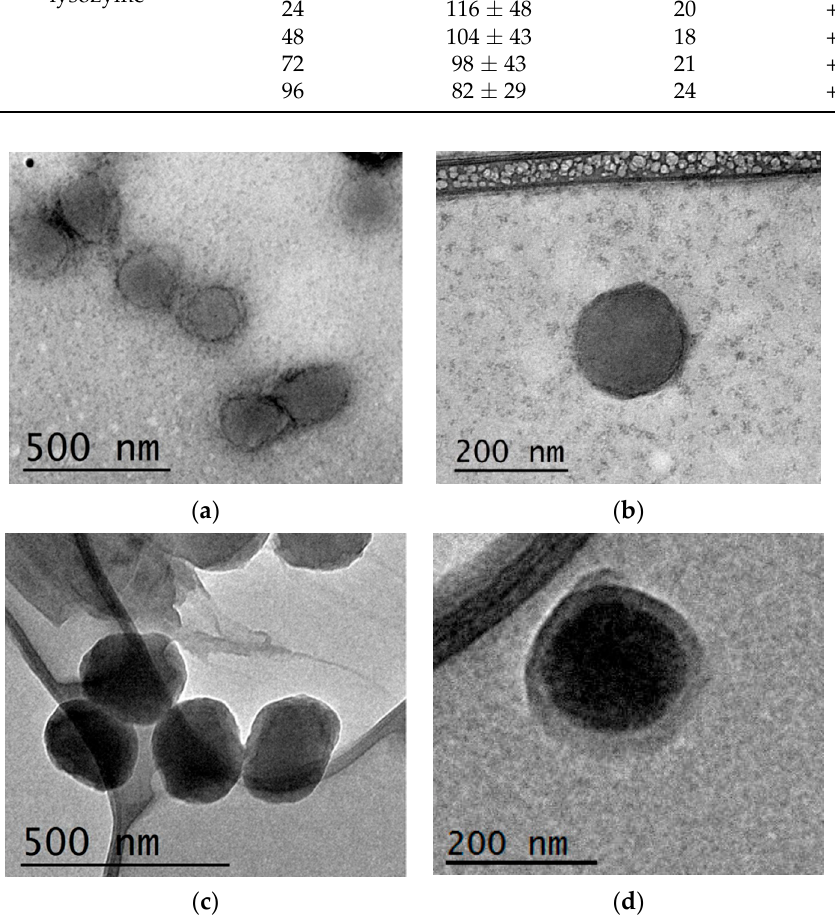
Figure 6. TEM images of LVF–CH/TPP 3 NPs ( a , b ) and LVF–CH/SBE- β -CD 3 NPs ( c , d